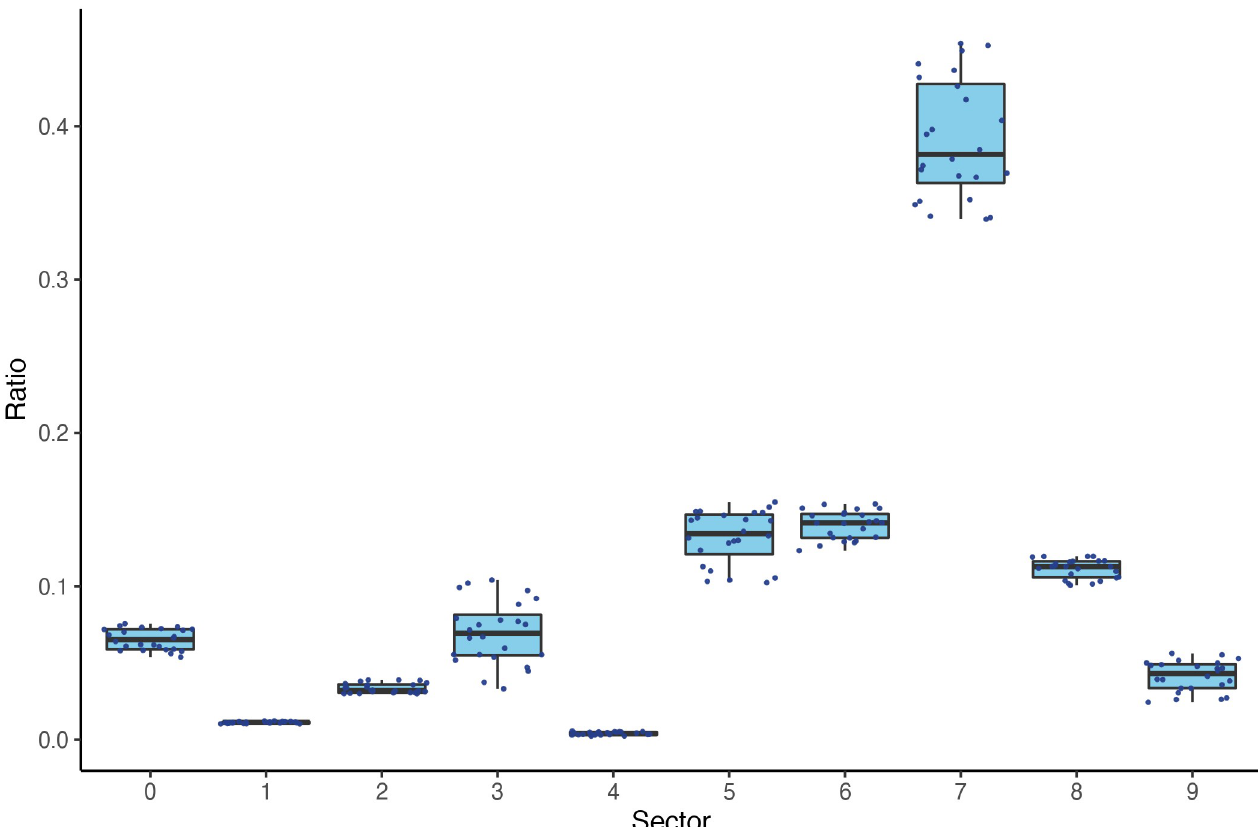
Fig 4. Share of sectors in total trade. The box plot shows the share of the 10 broad sectors in total trade among sample countries. Every dot represents the trade share of a given sector in a given year. The horizontal lines show the median of the given sector, the boxes represent the upper and lower quartiles around the median and the vertical lines reach out to minimum and maximum